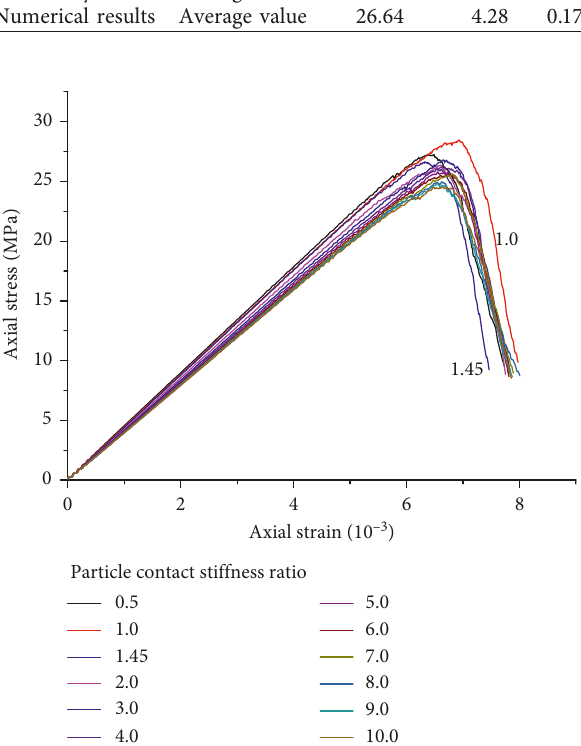
Figure 2: The stress-strain curves of different particle contact stiffness ratios are